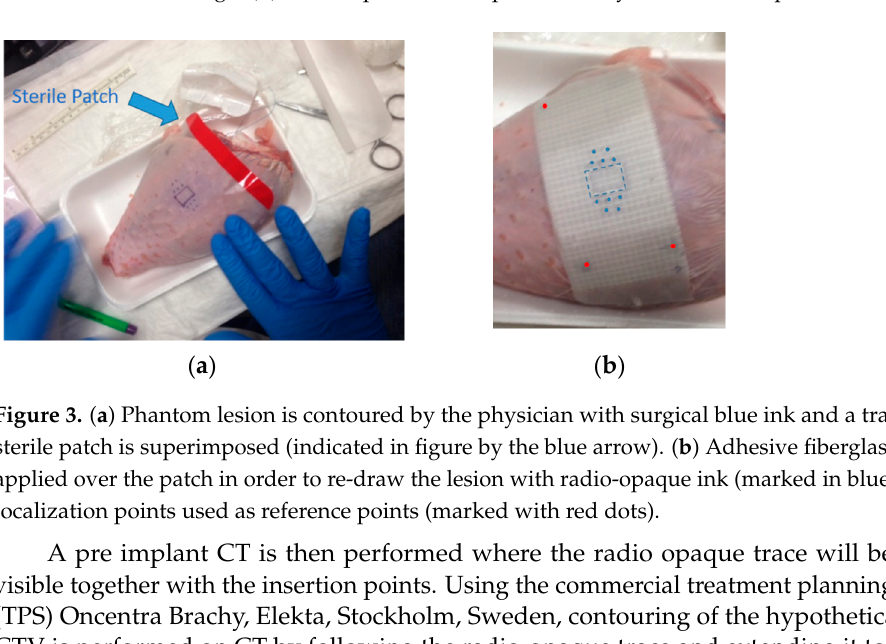
Figure 2. ( a ) Lesion is contoured by the physician directly on the skin of the patient and insertion points are theoretically marked with surgical blue ink. ( b ) Gross tumour volume (GTV) of the lesion is contoured on a PET/CT scan and clinical tumour volume is obtained as expansion of 4–6 mm of the GTV in order to account for microscopic tumour invasion and eventual patient swell during intervention. ( c ) Commercial TPS is employed to geometrically evaluate the number of seeds needed for full tumour coverage. ( d ) Seed implantation is performed by the radiotherapist.